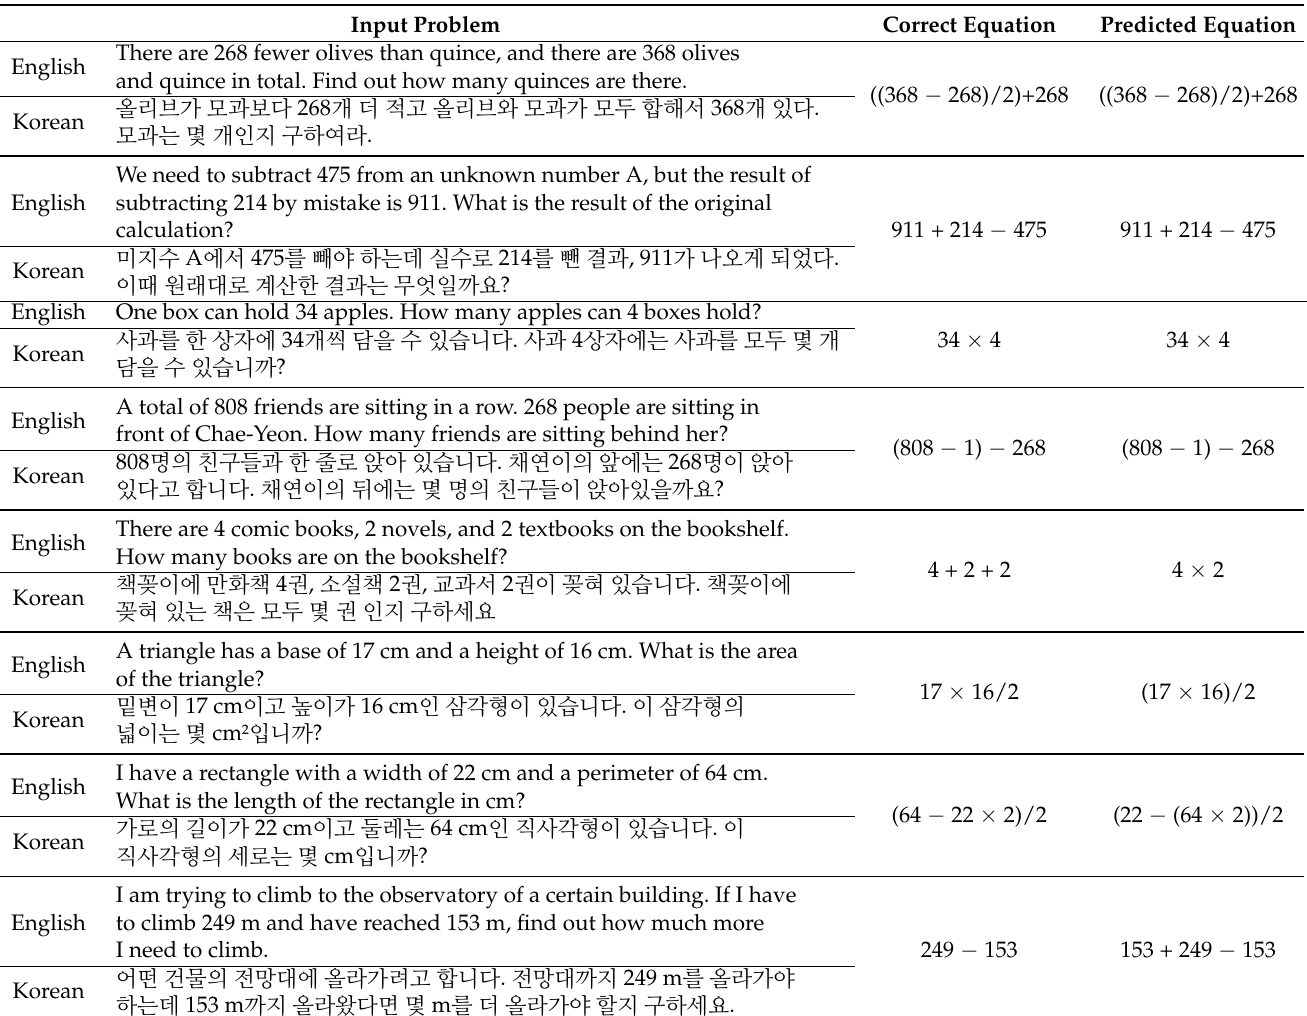
Table 10. Examples of correct and incorrect equations from the Transformer with FastText, which perform the best on the real-world problem